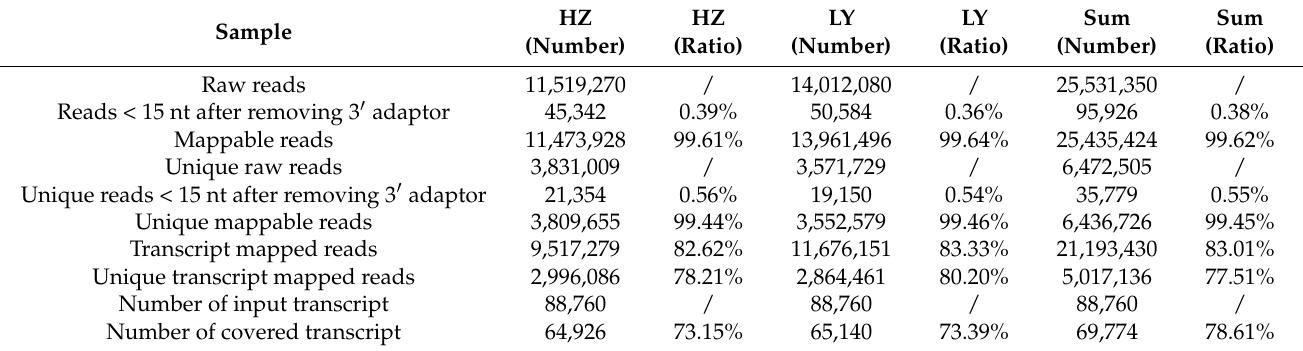
Table 2. Overview of reads from degradome